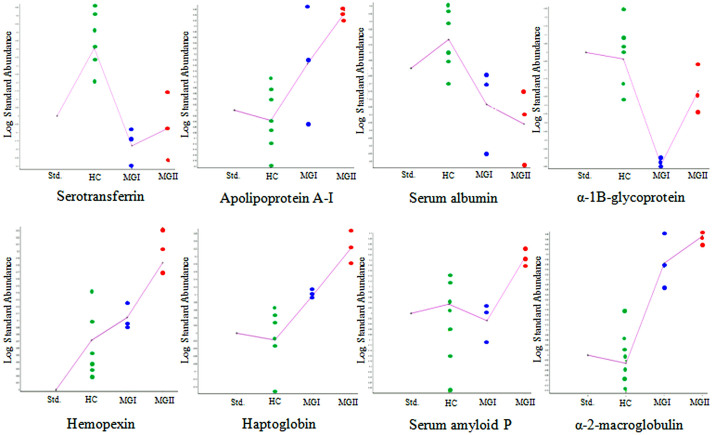
Differentially expressed serum proteins in different grades of meningiomas identified using 2D-DIGE.Trend of few selected differentially expressed serum proteins in different grades of meningiomas represented as standardized log abundance of spot intensity.